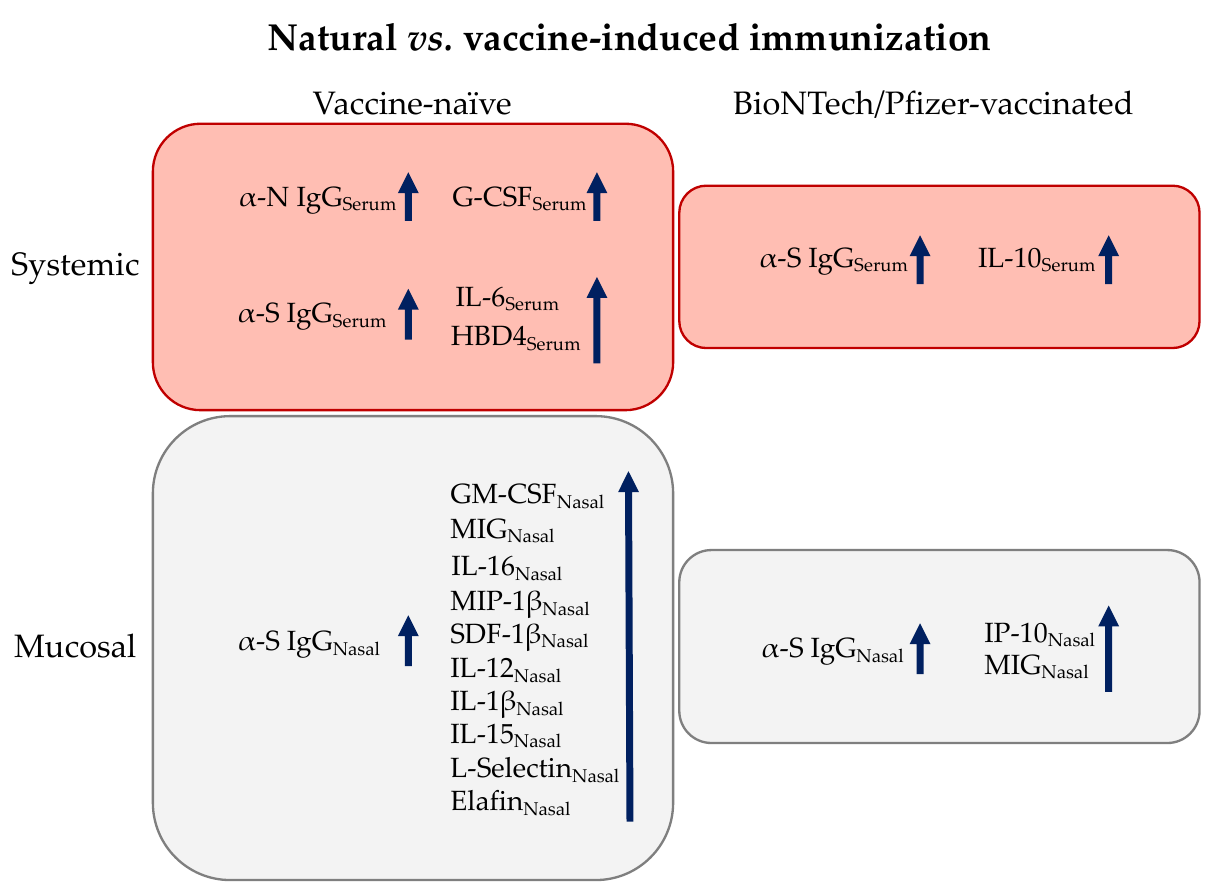
Figure 6 . Comparison of nasopharyngeal and systemic environment. Greater inflammatory background was observed mucosally rather than systemically; and correlations between local responses (antibodies vs. cytokines/chemokines) are compartment specific and antigen dependent. Blue arrow indicates sense of correlation between antibodies and cytokines/chemokines; i.e., both arrows in the same direction indicate a positive